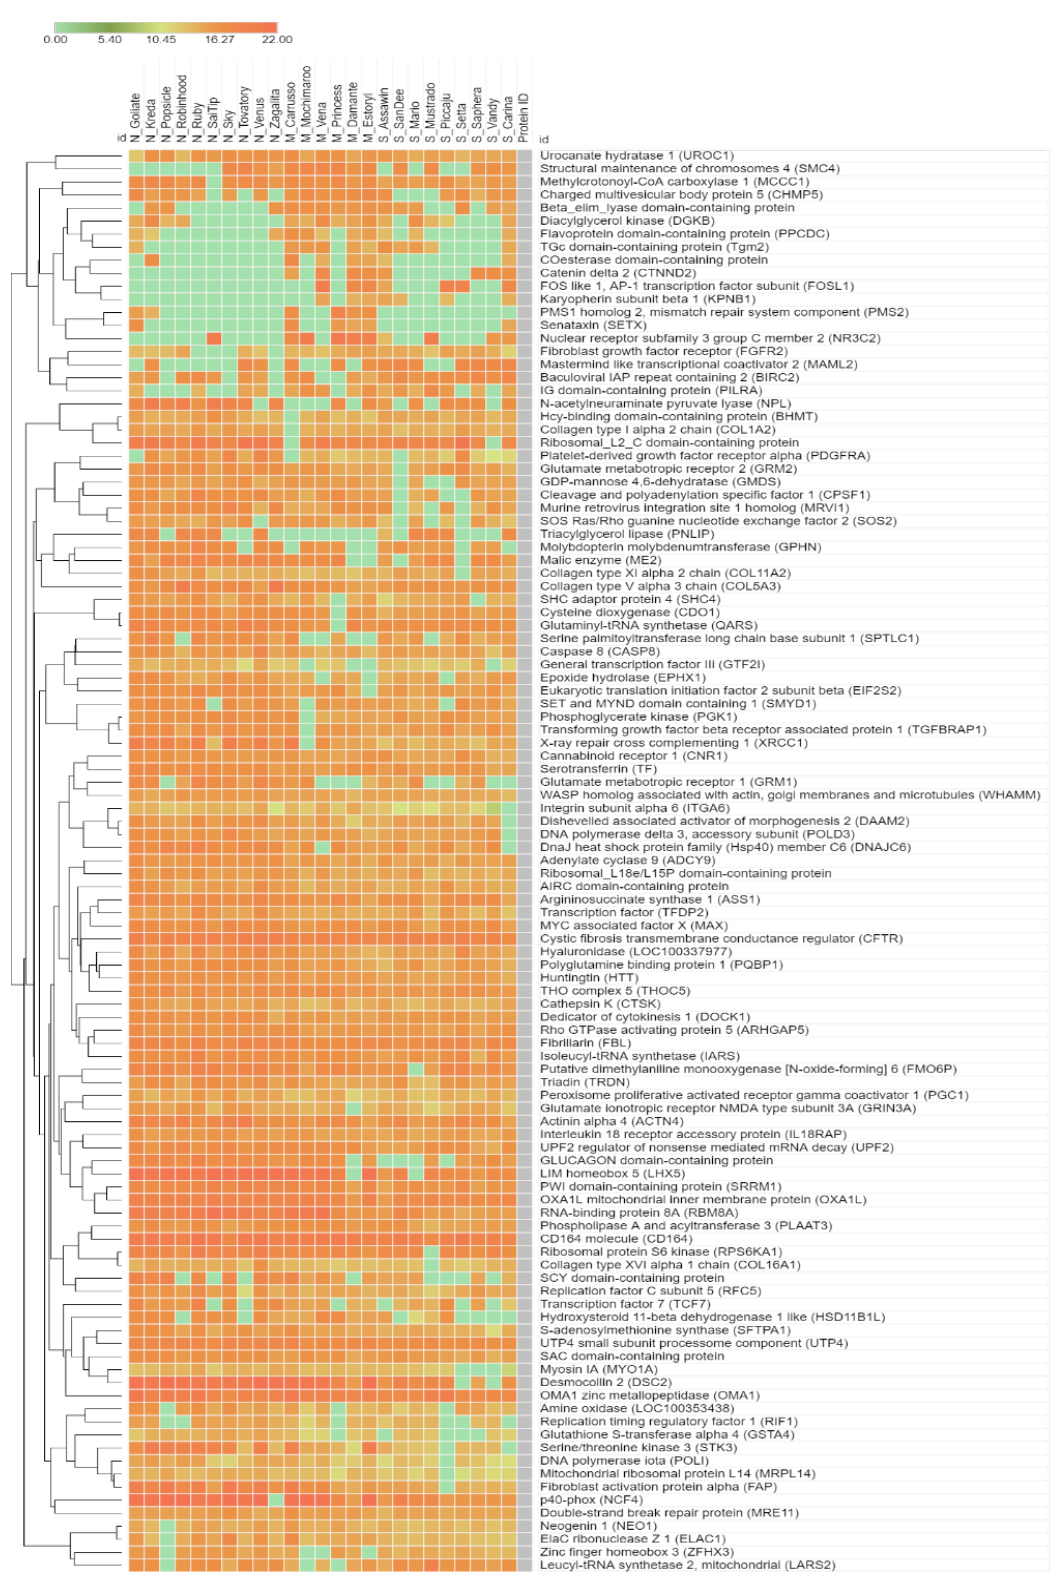
Figure 2. The comparative protein expression levels across a normal grey horse group, mild EMN group and severe EMN group. The heatmap is generated from the intensity of significant proteins database for each group using the CLUE program (https://clue.io/command, accessed on 10 September 2021). N, M and S represent normal, mild and severe, respectively.